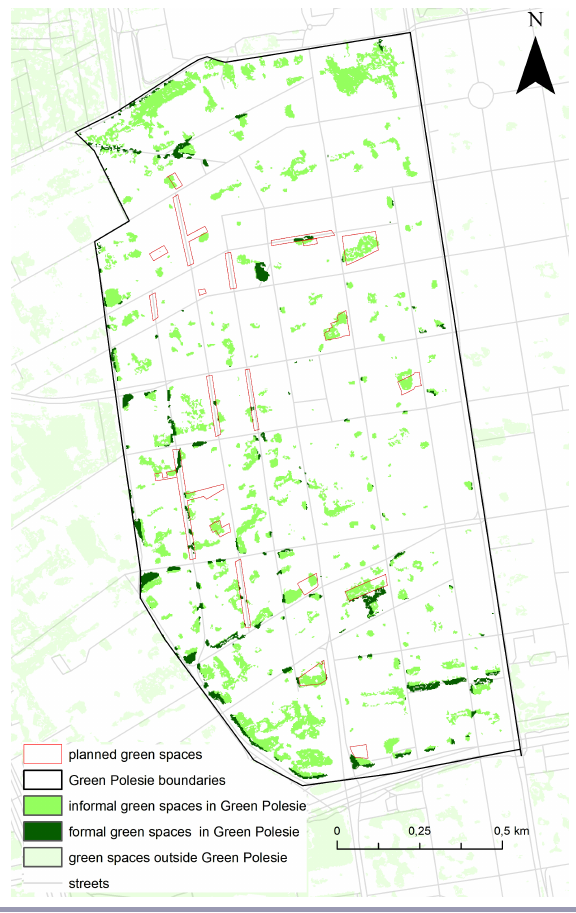
Fig. 3. Green spaces (formal and informal) available before the start of the Green Polesie initiative and those planned within this initiative (based on CAD files provided by the Municipal Planning